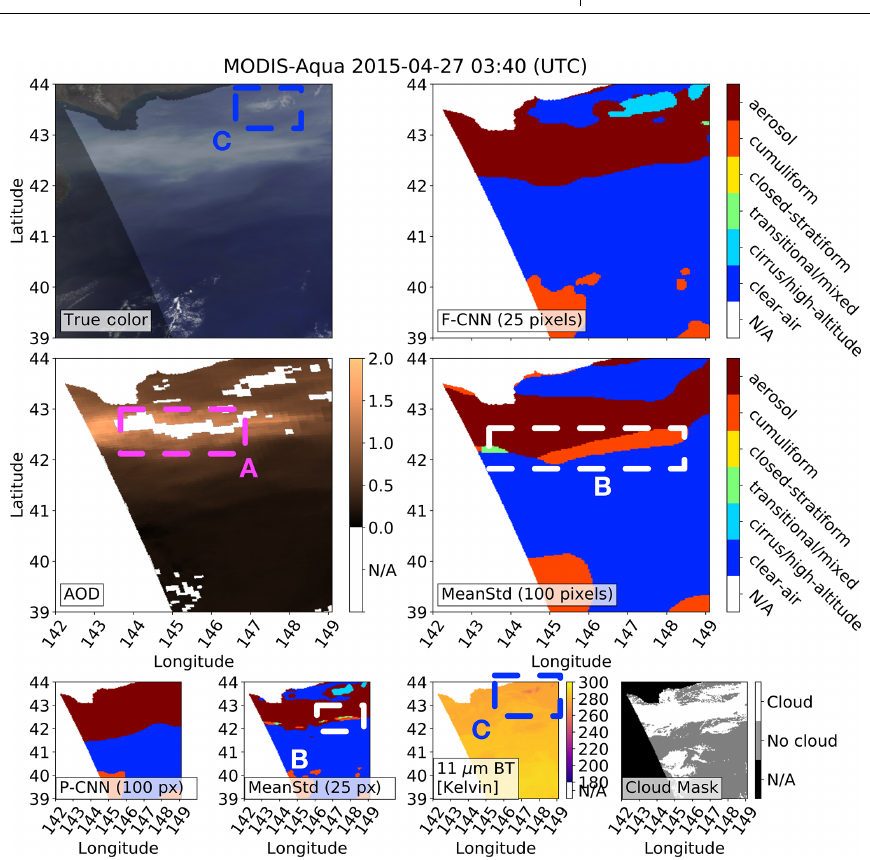
Figure 7. Box A shows where (1) the MODIS MYD04 aerosol product has aerosol optical depth (AOD) retrievals which are flagged as bad by the MYD04 quality control, (2) the MODIS MYD35 cloud-mask product labeled the aerosols as clouds, and (3) the pretrained 100-pixel CNN and fine-tuned 25-pixel CNN (F-CNN) methods were able to successfully detect the extreme aerosols. Box B shows where the baseline mean–standard deviation (MeanStd) method misclassified the aerosols as clouds. Box C shows the presence of sparse cirrus/high-altitude clouds with 11µm brightness temperatures (BTs) ranging between 249 and 257K and where the 25-pixel methods (F-CNN and MeanStd) were able to detect the cirrus/high-altitude cloud. For all images any sun glint and landmasses have been masked